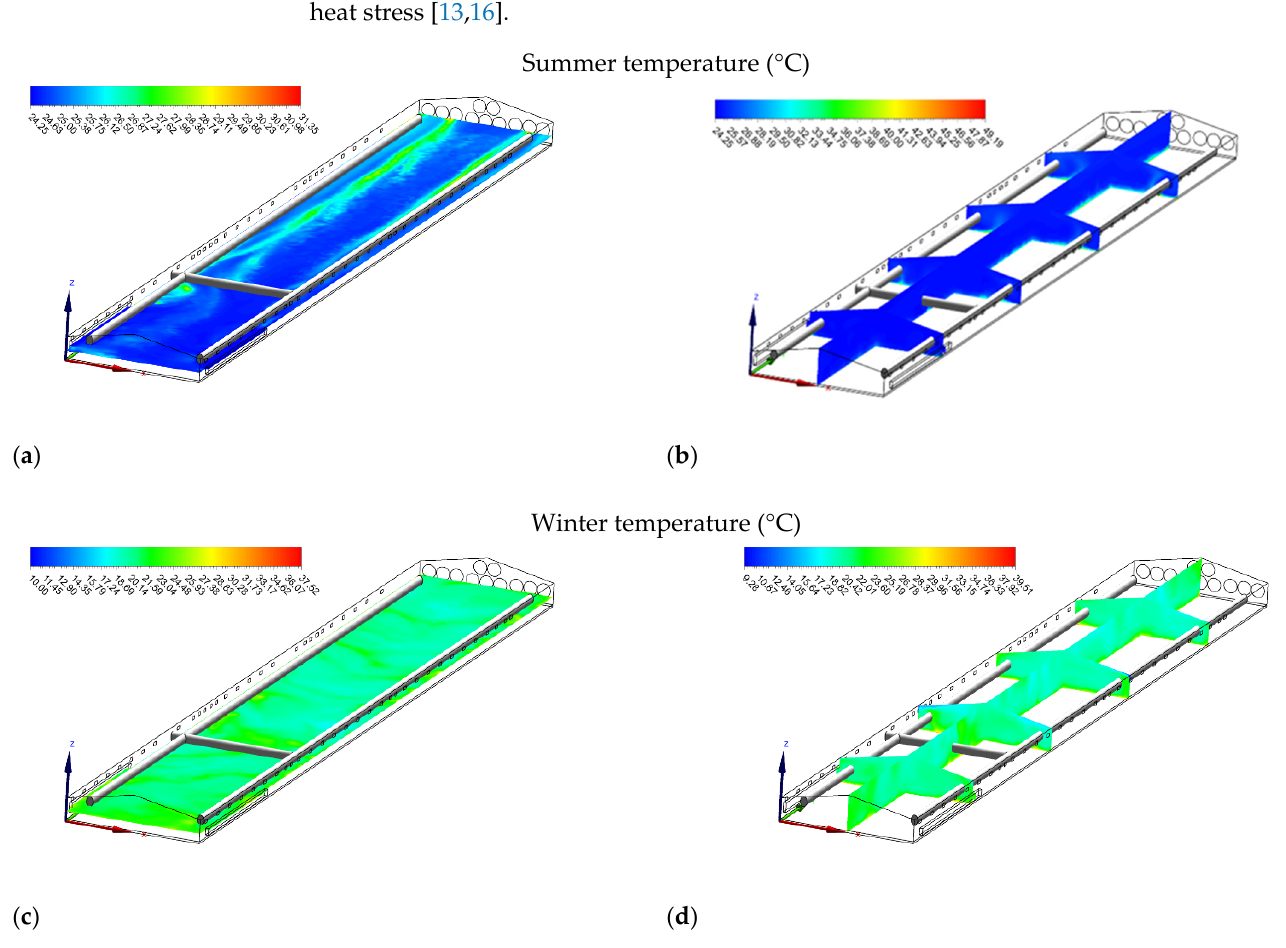
Figure 6. Temperature (°C) contours of slice: z = 1 m, and y 1 = 15 m, y 2 = 35 m, y 3 = 55 m, y 4 = 75 m, and x = 7 m for summer ( a , b ) and winter ( c , d ).